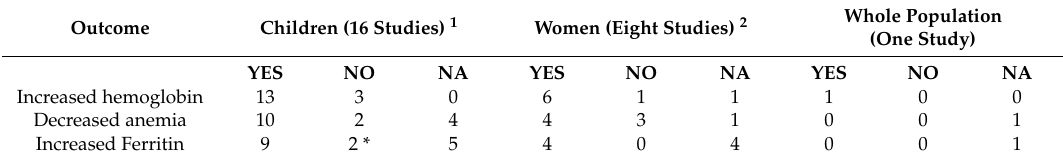
Table 2. Studies with statistically significant changes in markers of anemia and iron status. Outcome Children (16 Studies) 1 Women (Eight Studies)